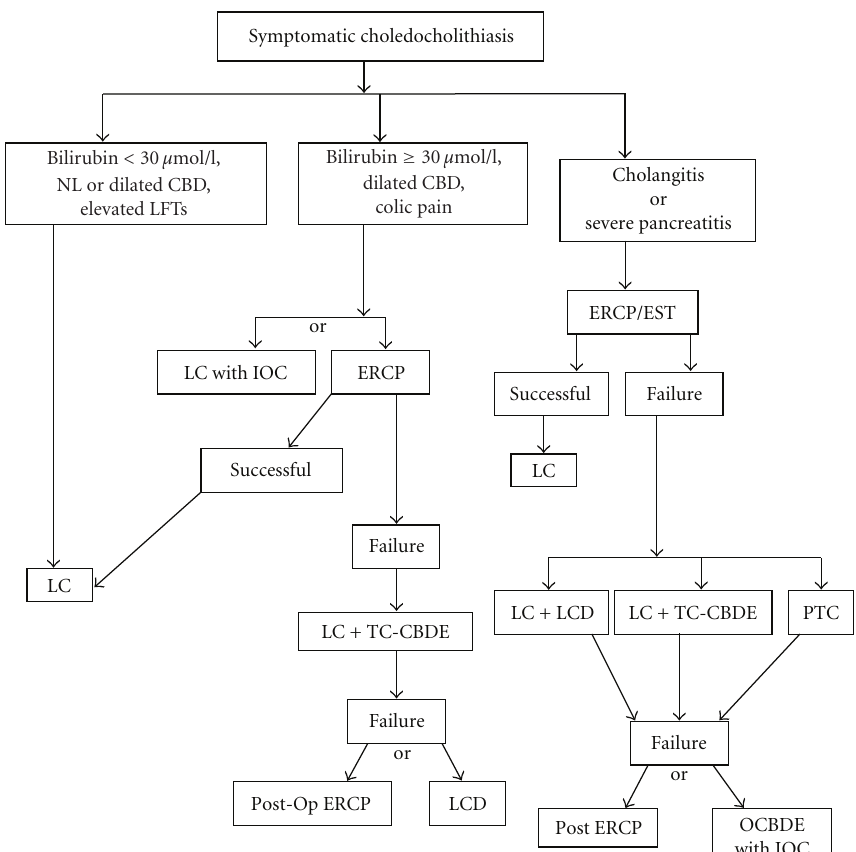
Figure 1: Algorithm for management of common bile duct stones. LC: Laparoscopic cholecystectomy, LCD: Laparoscopic choledochotomy, PTC: Percutaneous transhepatic catheter drainage, TC-CBDE: Transcystic common bile duct exploration, OCBDE: Open common bile duct exploration, IOC: Intraoperative